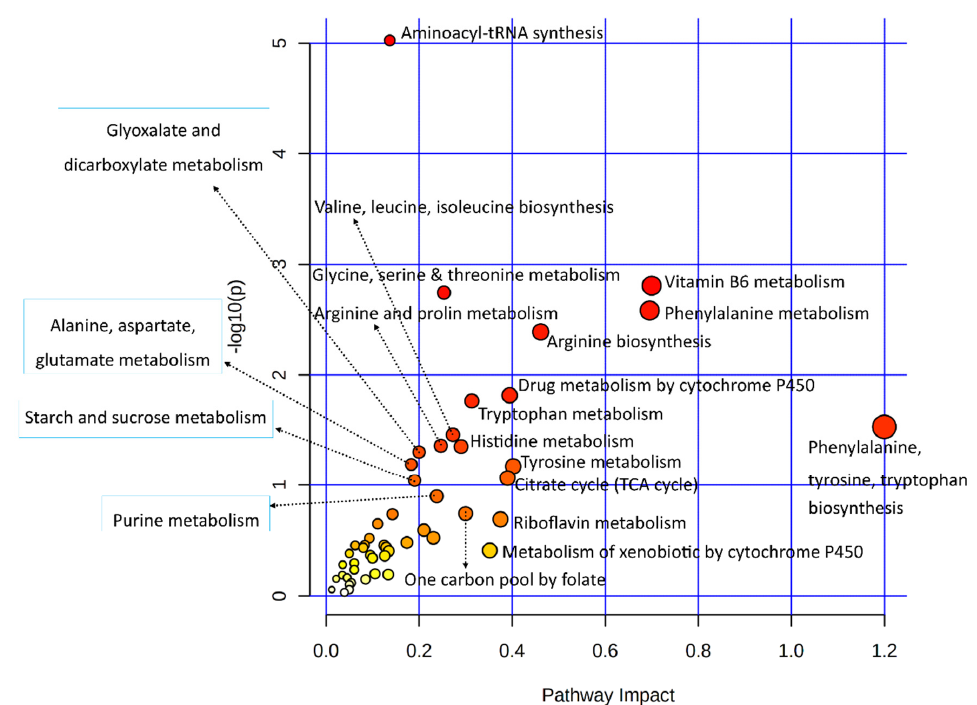
Figure 5. A dot plot illustration of the metabolic pathway enrichment in a joint analysis of significantly differentially expressed genes and important metabolites from transcriptome and metabolome data, respectively. Various metabolic pathways in the upper and left quadrants are labeled. The dot sizes increase with the increasing pathway impact; the color intensifies according to the y -axis.